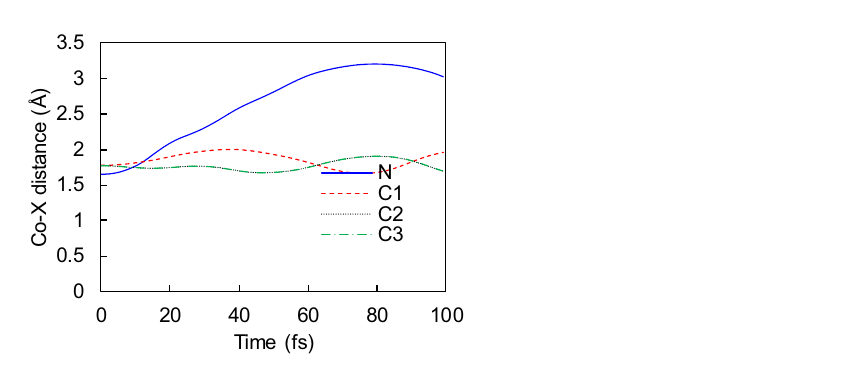
Figure 6. Co–N bond breaking driven by a two-electron excitation from the HOMO to the LUMO. This excitation can be achieved during electron-Co(CO) 3 NO scattering 57,58